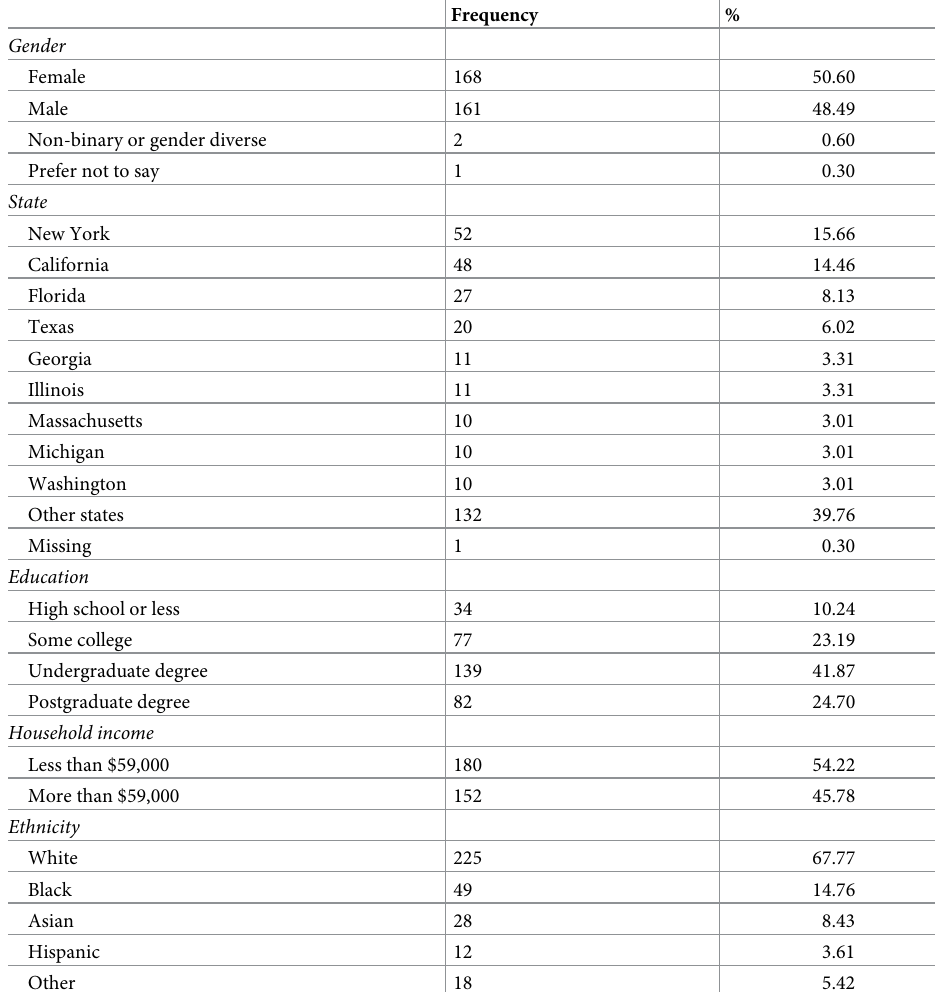
Table 1. Respondent